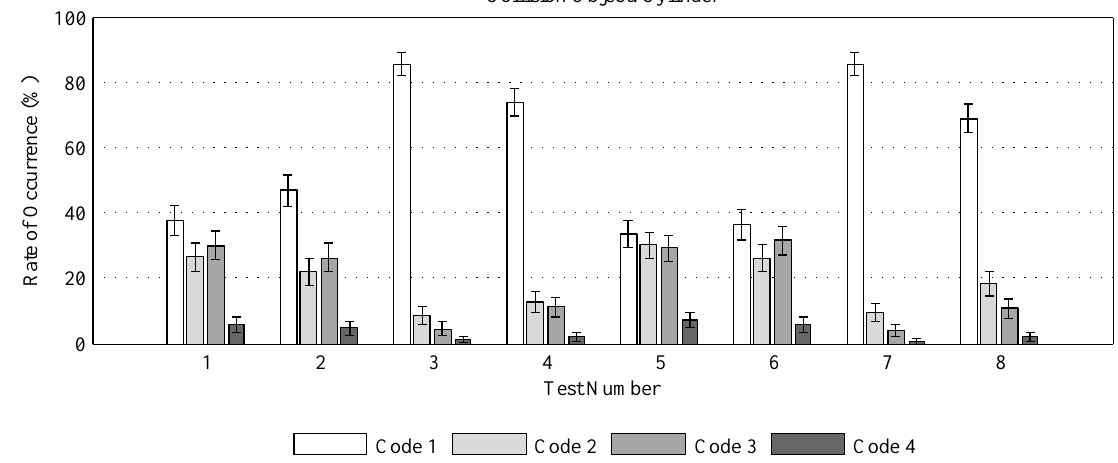
Figure 10. Summary of bead passage codes for cylinder tests, showing 95% confidence interval of observed rates.